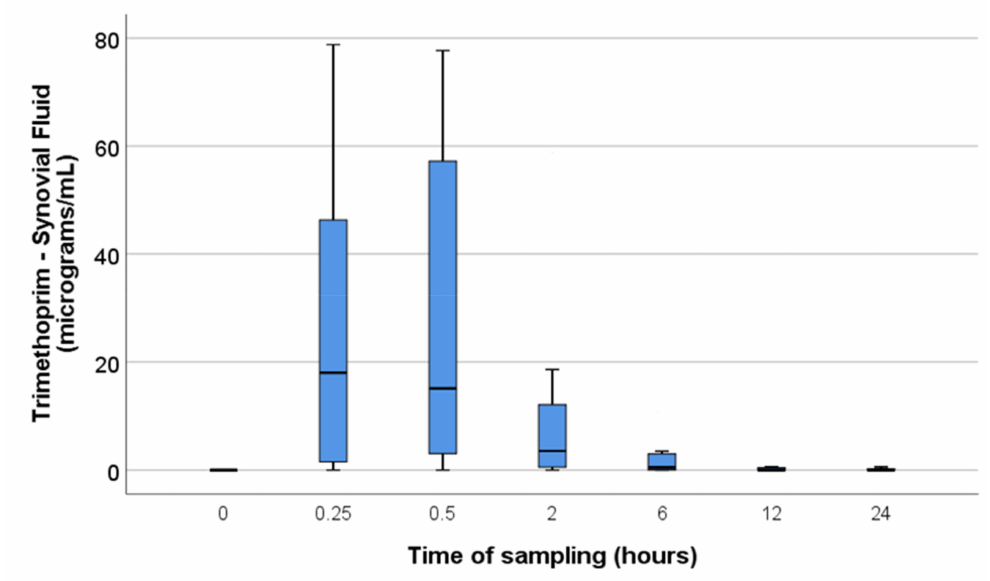
Figure 1. Trimethoprim synovial fluid concentrations at each time point. Median values and quartiles indicated by boxplots with maximum and minimum values indicated by whiskers. Synovial fluid concentrations were only significantly different from the concentrations at T0 at time points 0.25 and 0.5 h, although the median synovial fluid concentration remained above the MIC (0.5 µ g/mL) until the 6-h time